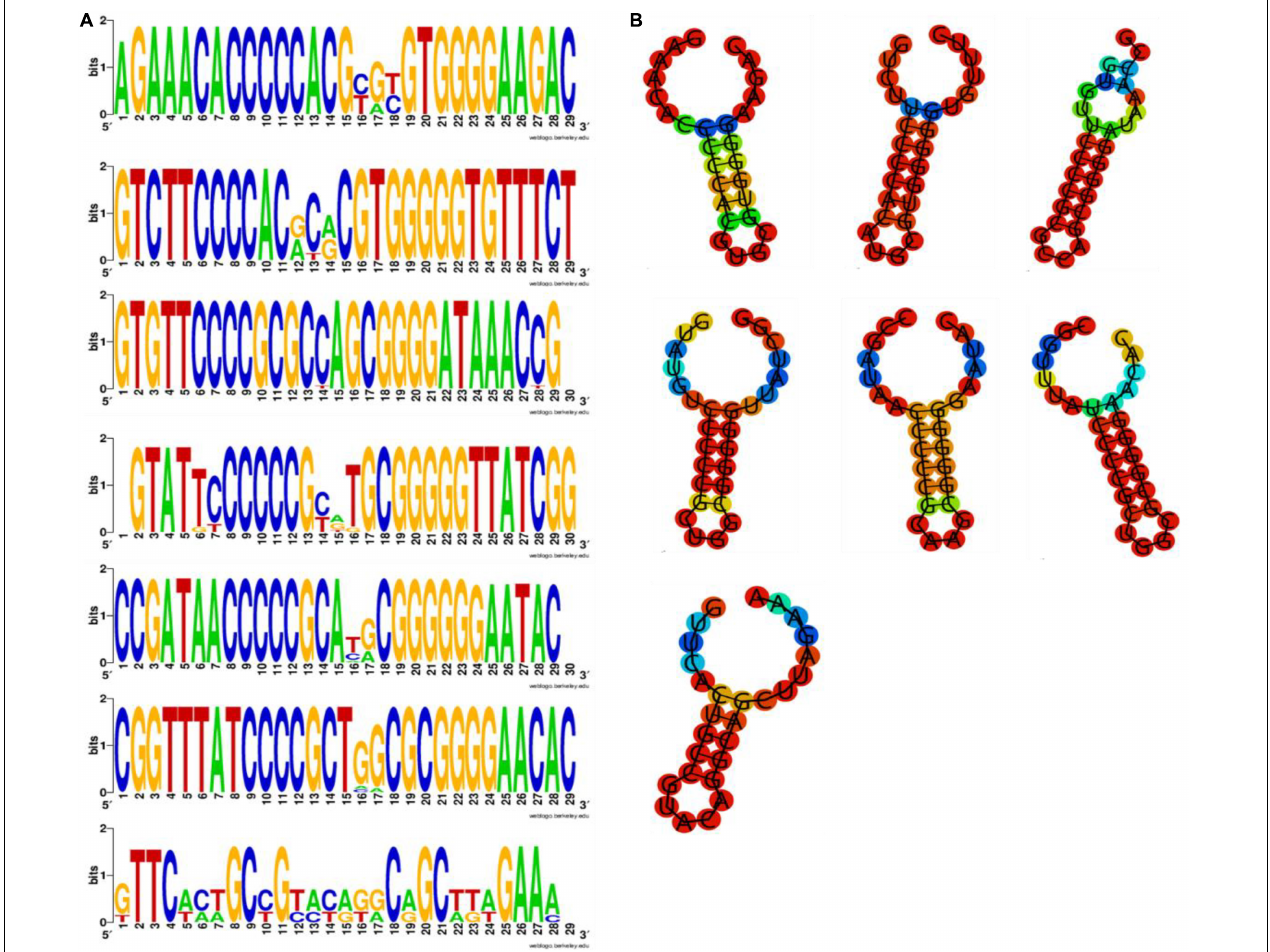
FIGURE 1 | (A) The weblogo of repeats of CRISPR1 ∼ CRISPR7. The sequence were first and terminal repeats of CRISPR1 ∼ CRISPR7. (B) The secondary structure of repeats of CRISPR1 ∼ CRISPR7. Secondary structure prediction of the most frequent sequence of the first and terminal repeats of each CRISPR was performed by RNAfold. The free energy of the thermodynamic ensemble was − 11.60, − 11.70, − 15.20 − 11.80, − 12.70, − 14.20, − 8.60